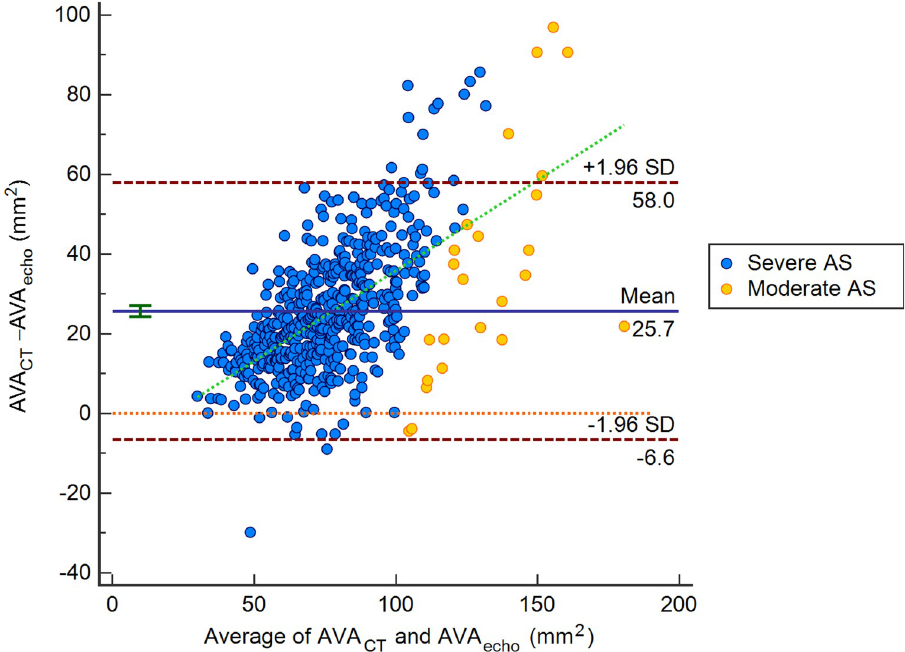
Fig 3. Bland-Altman plot of AVA echo and AVA CT . AS, aortic stenosis; AVA, aortic valve area; SD, standard